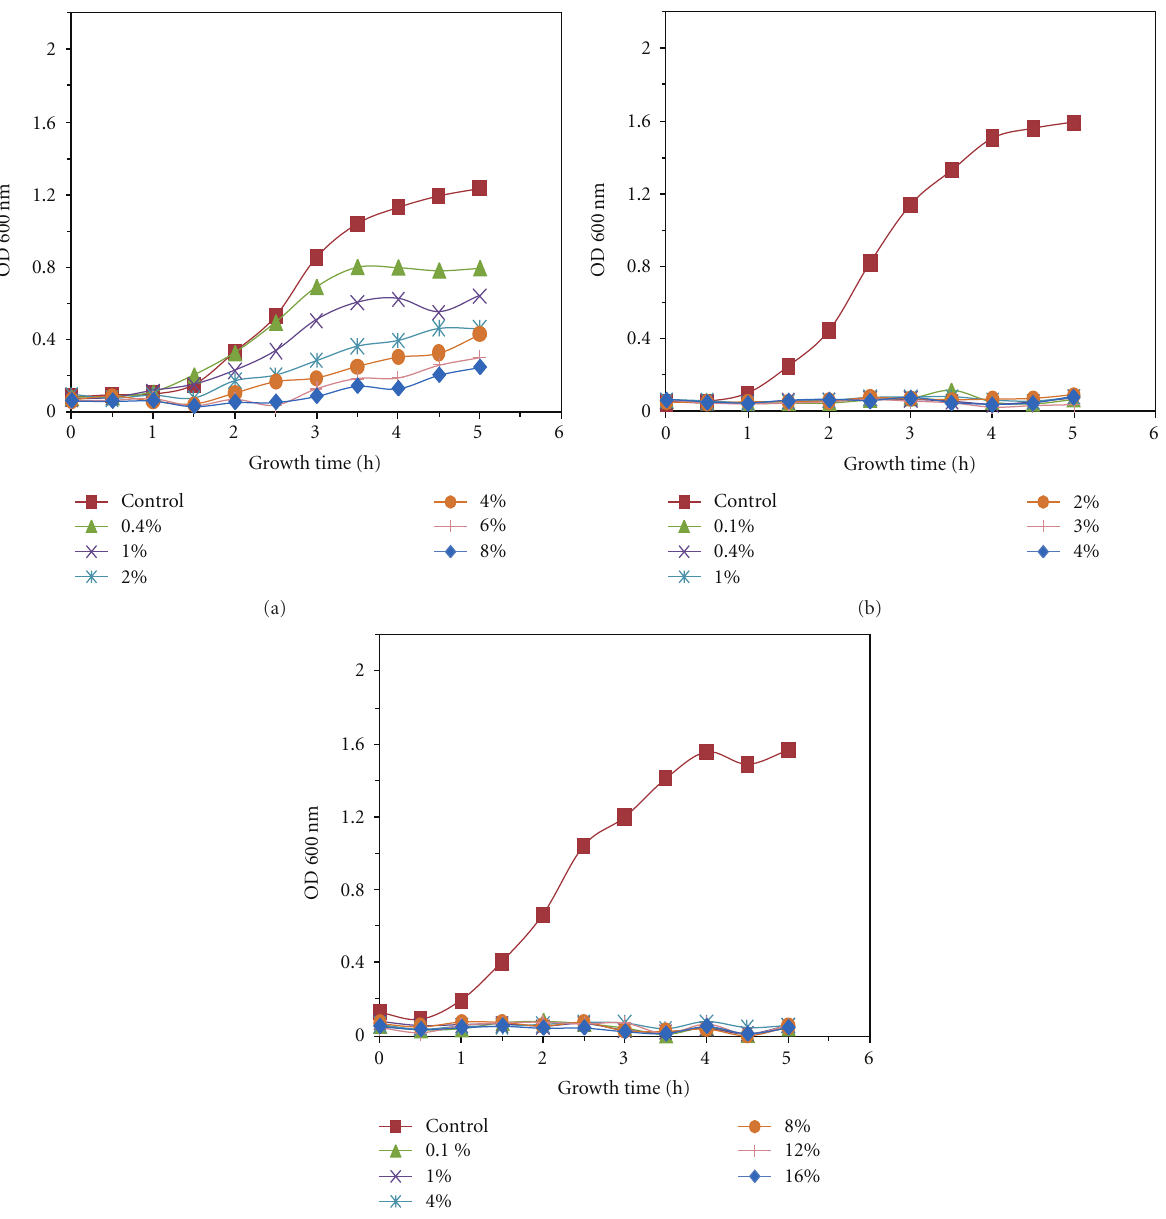
Figure 3: OD growth curves of E. faecium after treatment with surfactant-only solutions and incubation for 1h: (a) treated with 0.4, 1, 2, 4, 6, and 8% SC; (b) treated with 0.1, 0.4, 1, 2, 3, and 4% SDBS, and (c) treated with 0.1, 1, 4, 8, 12, and 16% SDS. Other conditions are the same as in Figure